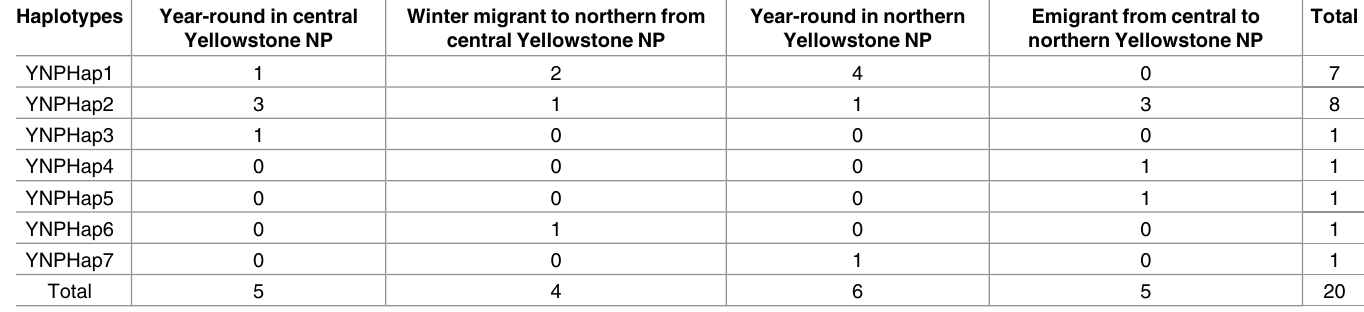
Table 2. Mitochondrial haplotypes based on different life history strategies. Only the migration status of the 20 animalsin the radio telemetry study were knownand included.